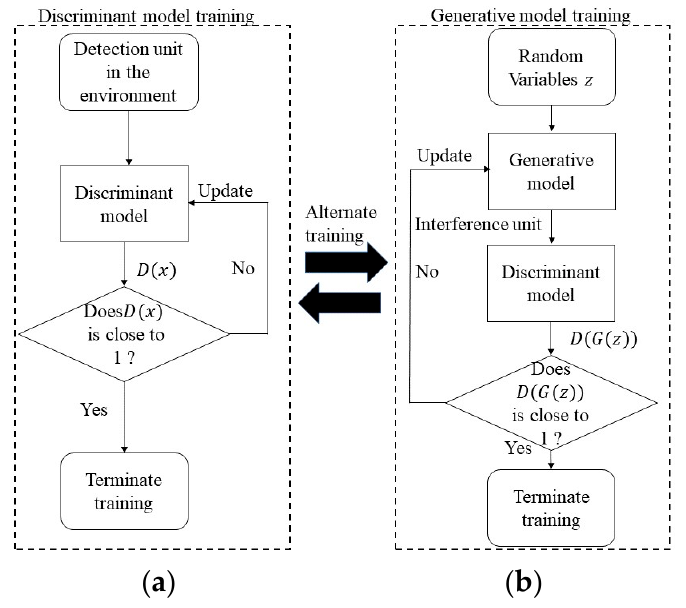
Figure 3. Generative adversarial network training flow chart: ( a ) discriminant model training; ( b ) generate model training.